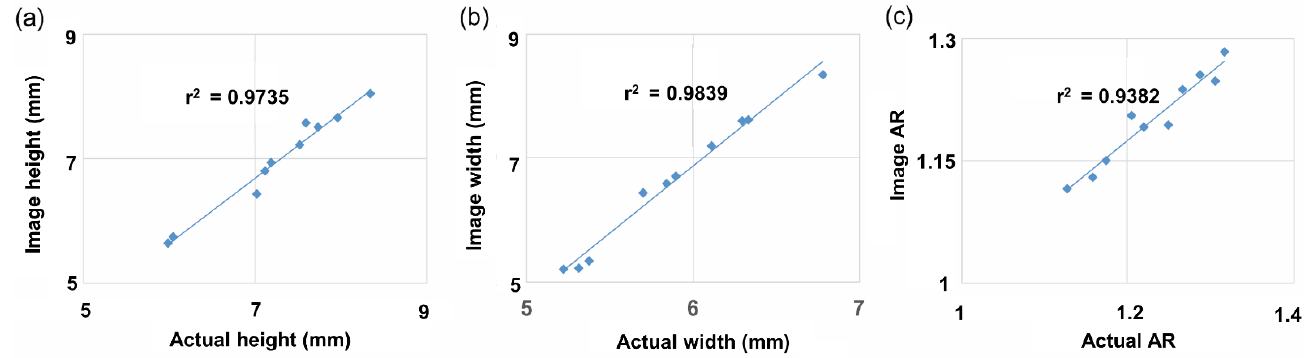
Figure 5. Correlation between actual and image measurement of randomly selected 10 germplasms. Thirty seeds for each germplasm were repeated and measured with vernier calipers. ( a ) Height, ( b ) width, ( c ) AR.